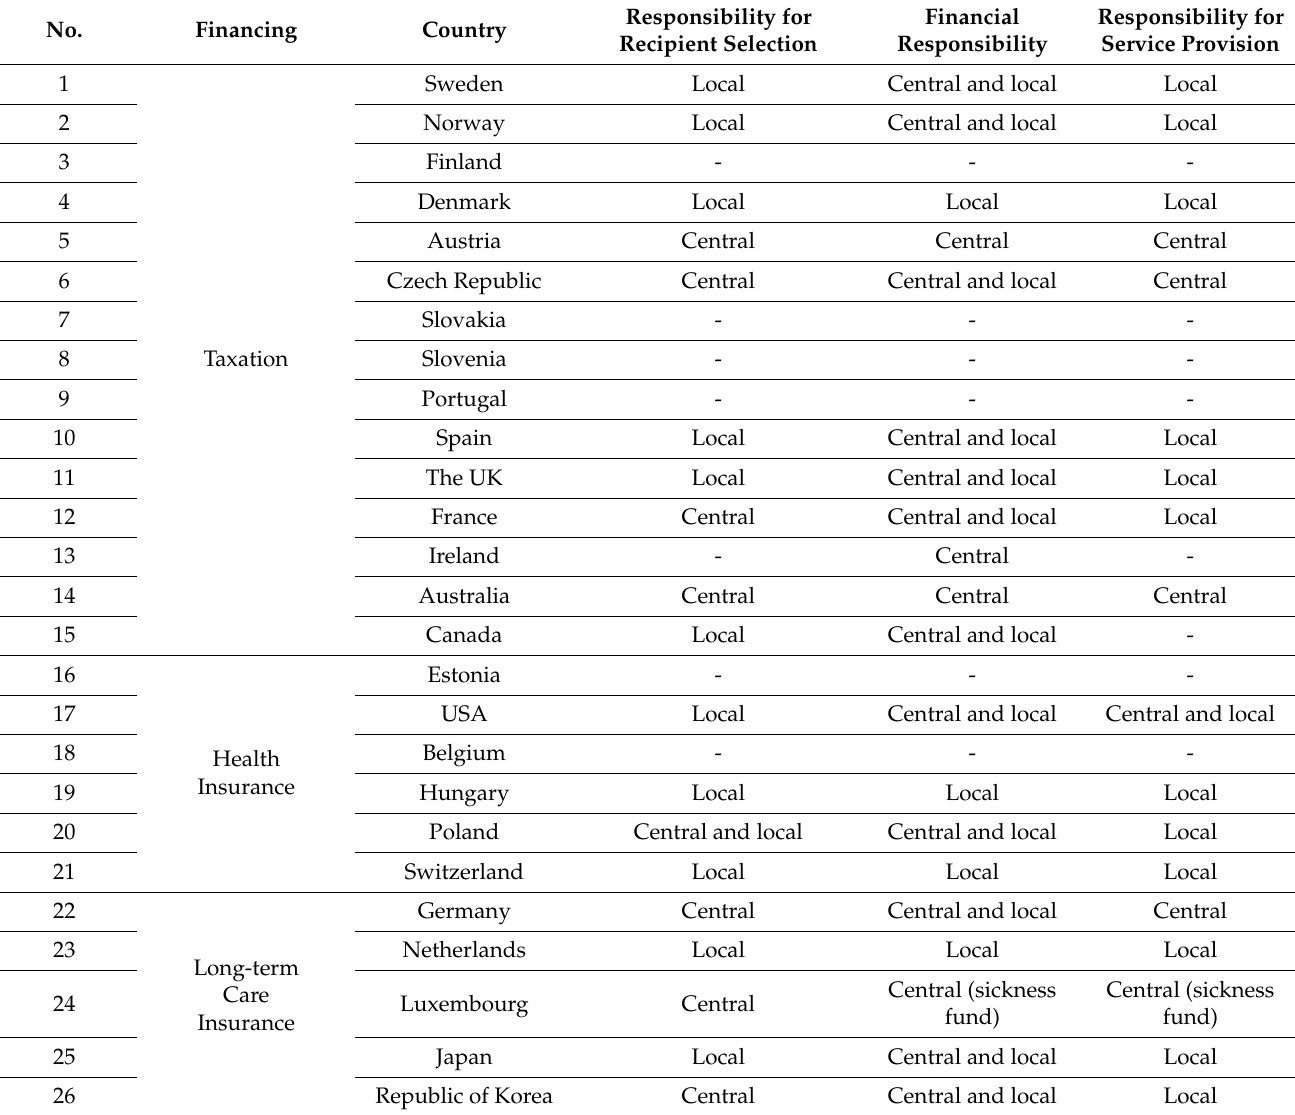
Table 7. The role of central and local governments in service delivery systems